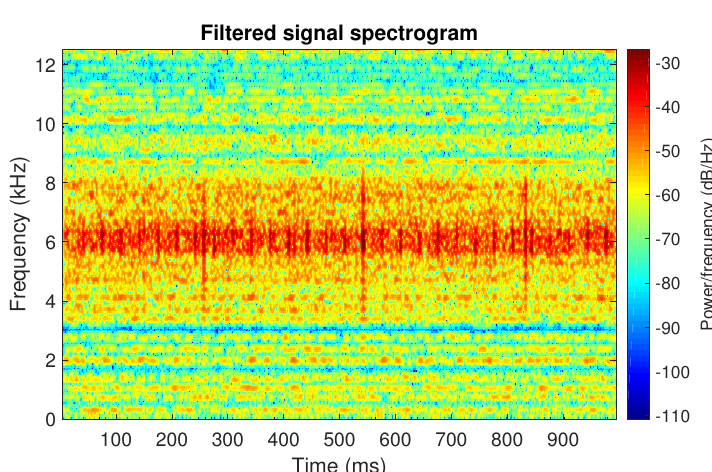
Figure 32. Filtered signal s 4 by Alpha selector.